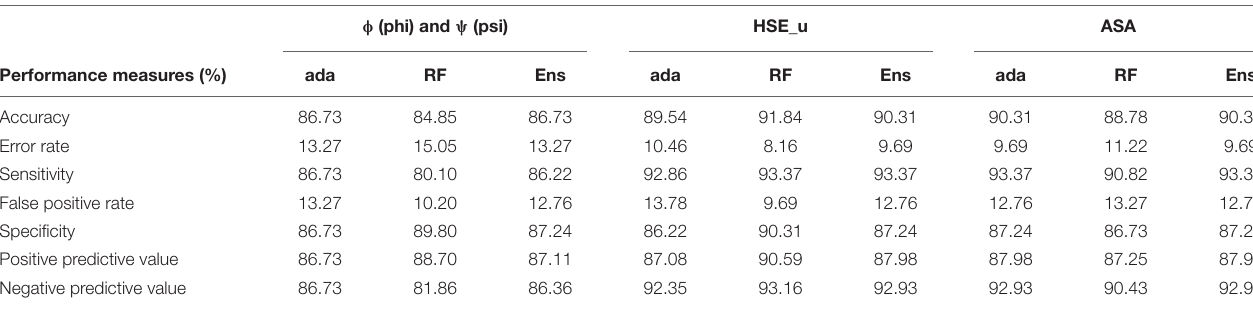
TABLE 4 | Machine learning performance measures for predicting exportome membership using backbone torsion angles φ (phi) and ψ (psi), half-sphere exposure (HSE) upper sphere predictions, and solvent-accessible surface area (ASA). φ (phi) and ψ (psi) HSE_u